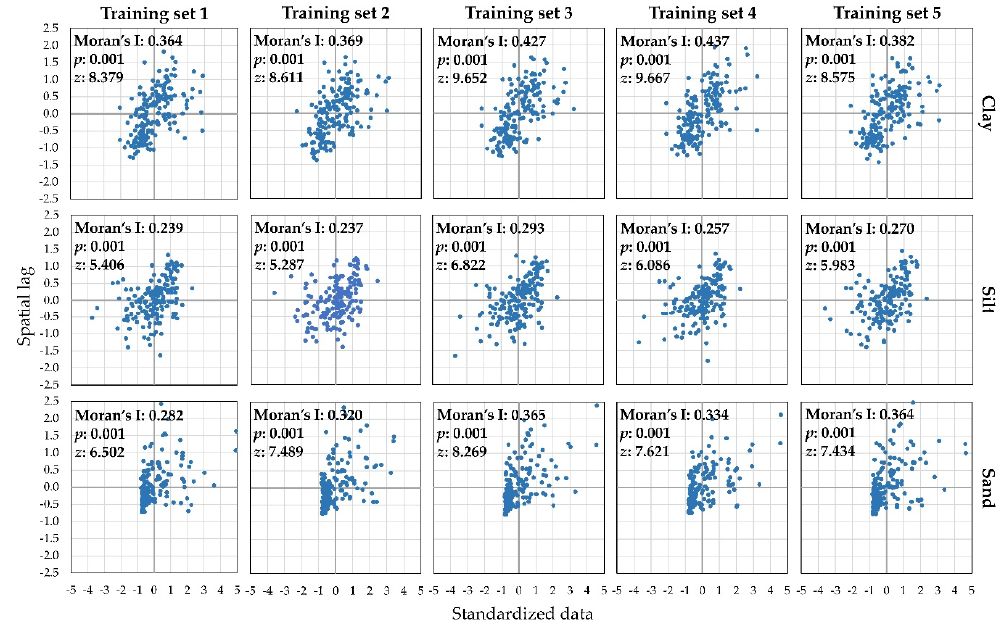
Figure 5. Moran scatterplots for five training sample sets for clay, silt and sand.